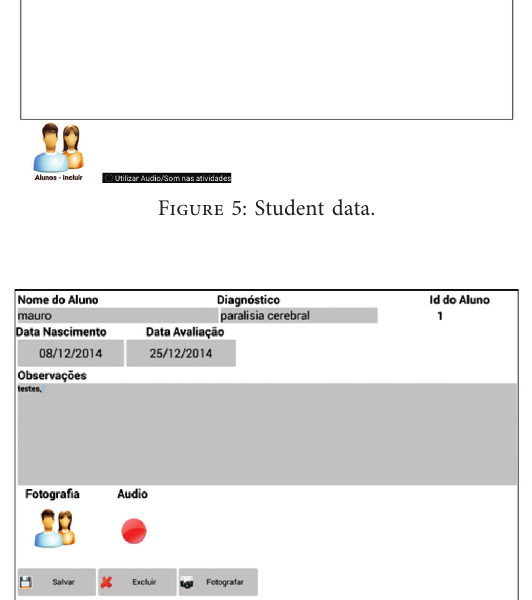
Figure 6: Personal data of the